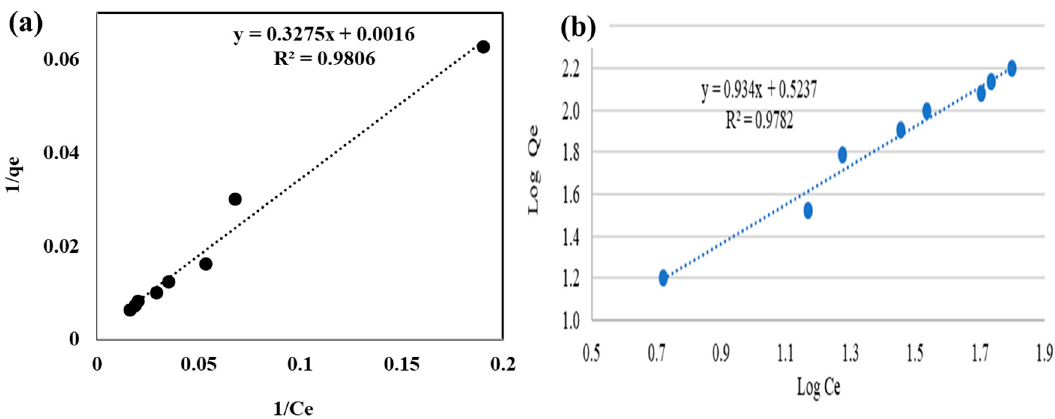
Figure 7. ( a ) Reciprocal linearization, and ( b ) logarithmic linearization of the Cr(VI) adsorption iso- therm. isotherm.